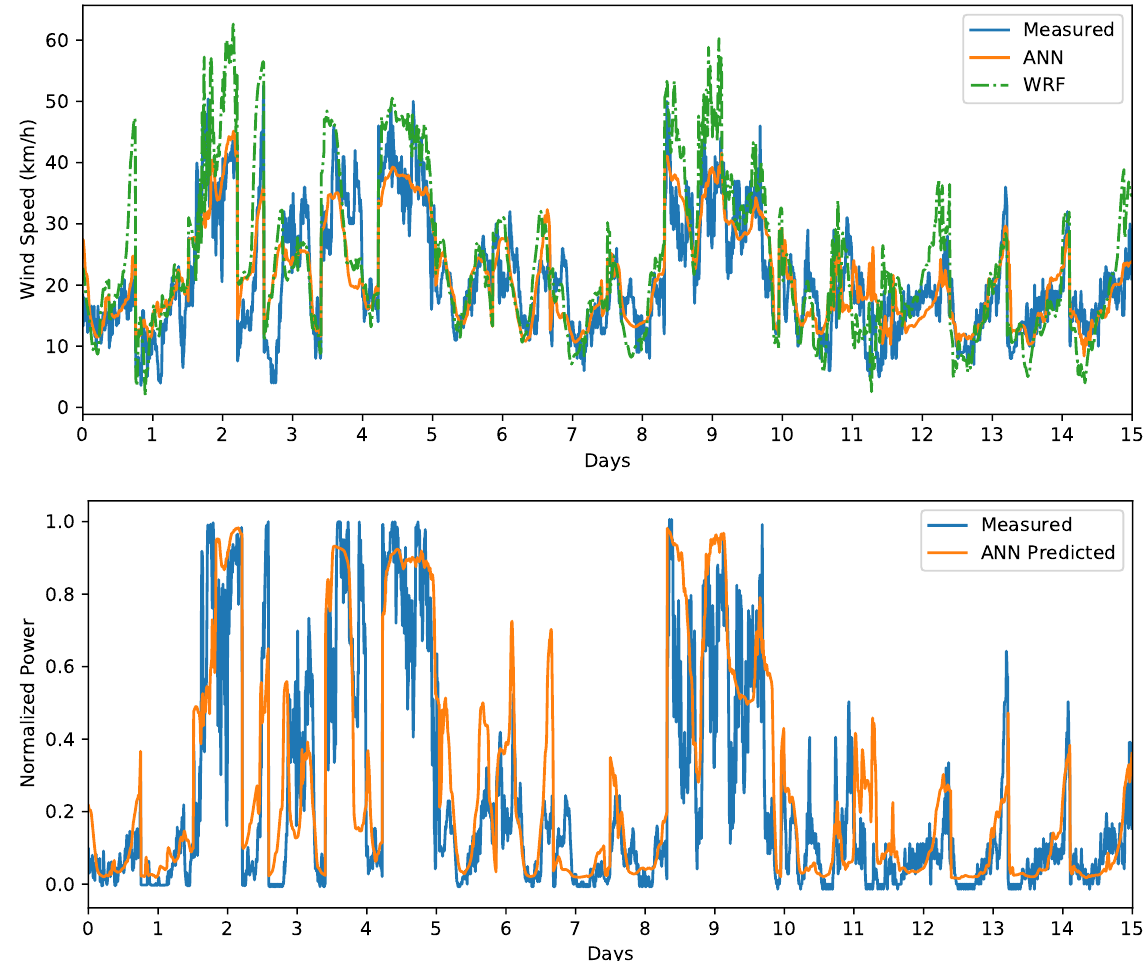
Figure 8. Time series results of measurement and two different ANNs. The upper panel shows the wind speed measured and predicted by WRF and the ANN of the hybrid model, whereas the lower panel shows the power measured and predicted by the direct ANN model. The data shown here corresponds to the validation set of one turbine and the power is normalized by the maximum of measured values. The days illustrated in the figures are not continuous since the validation set is composed of randomly selected days from the original data